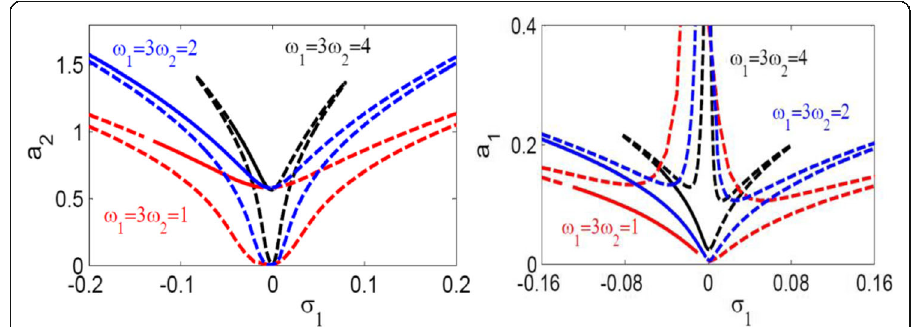
Fig. 7 Effects of the natural frequency ω